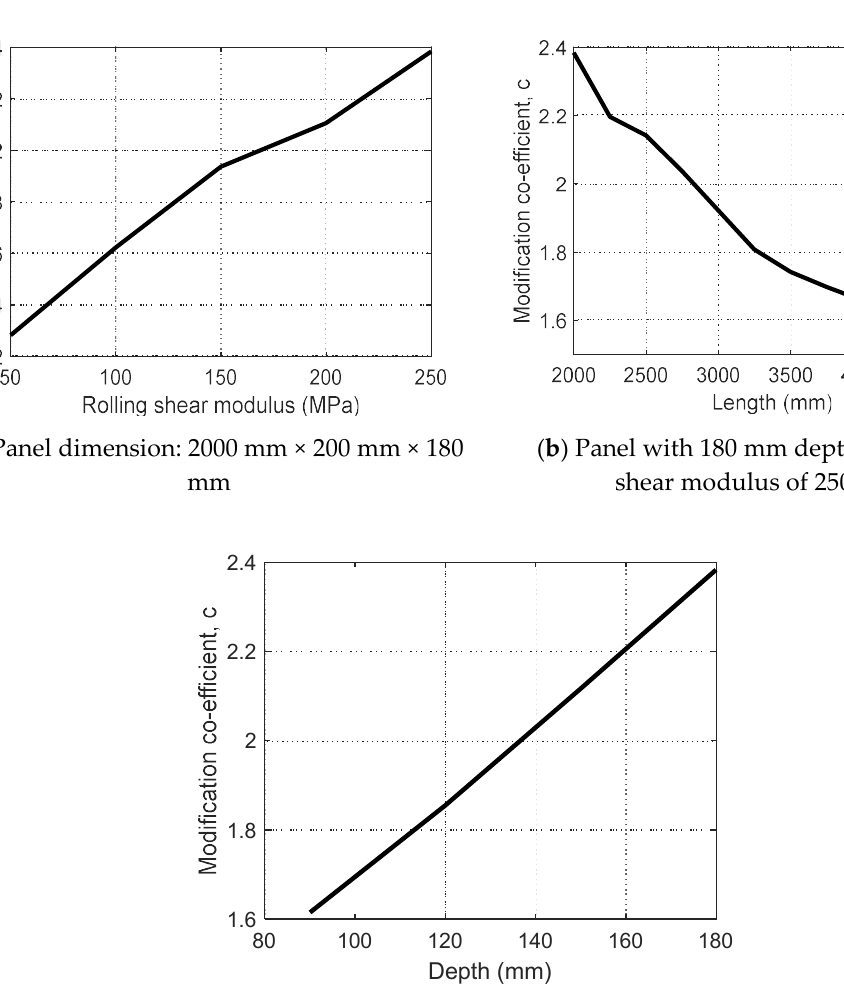
Figure 14. Variation of the proposed modification co-efficient with ( a ) Rolling shear modulus, ( b ) Length and ( c ) Depth.